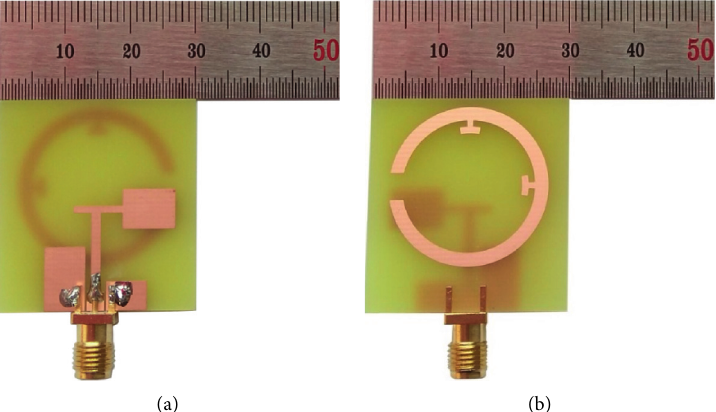
Figure 9: Photographs of the fabricated antenna: (a) front view, (b) back